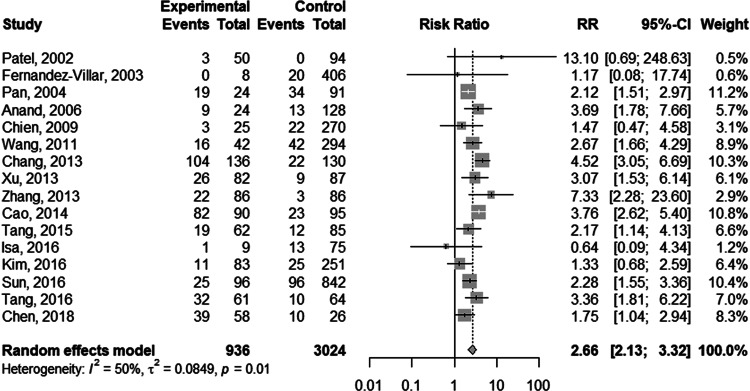
Forest plot of the association between HBV infection and the risk of anti-TB DILI.